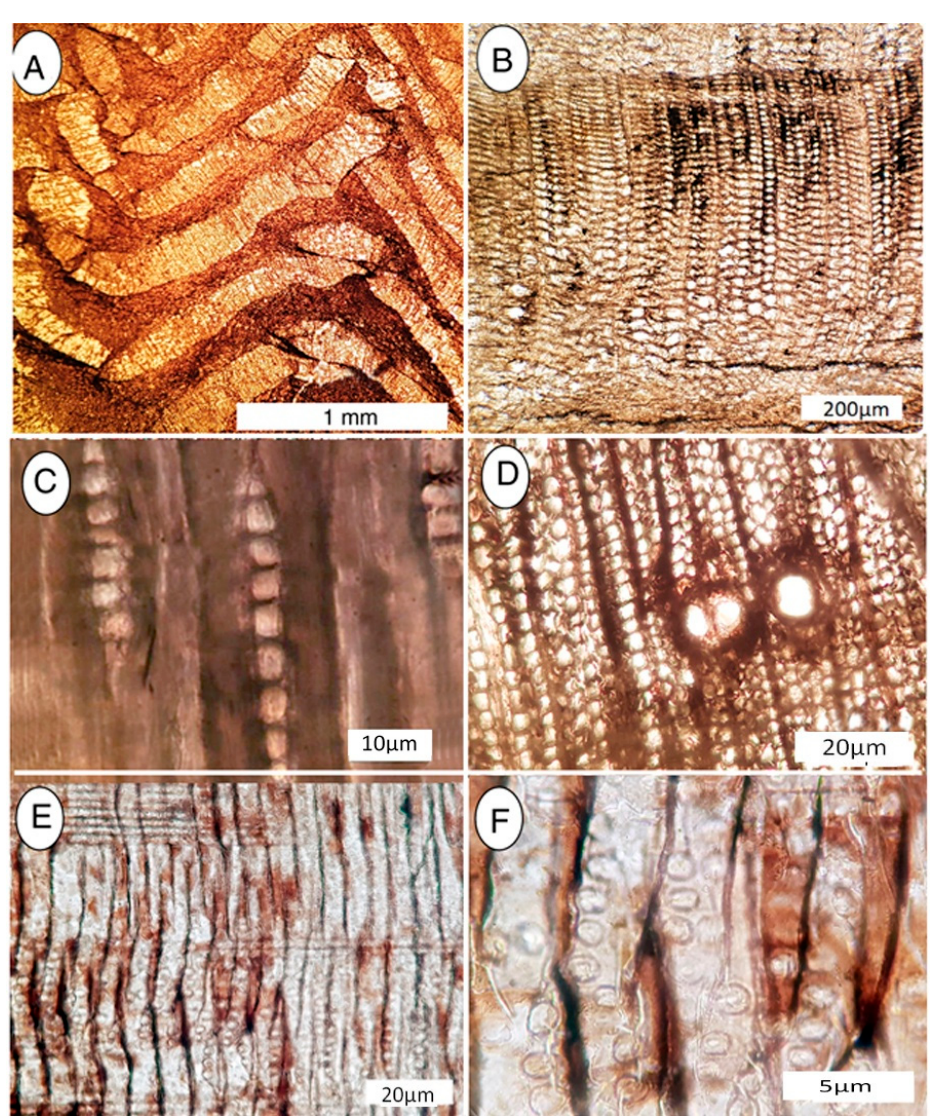
Figure 8. Anatomical characteristics of gymnosperm wood from Meshgin Shahr Fossil Forest. ( A )Transverse view, Trunk 8, showing distortion and compression of annual growth rings. ( B ) Transverse view, Trunk 4, displaying gradual transition between earlywood and latewood. ( C ) Tangential view, Trunk 12, uniseriate ray cells seen in cross section. ( D ) Transverse view, Trunk 12, showing resin canals. ( E ) Radial view, Trunk 7, with fusiform tracheids and horizontal ray cells. ( F ) Radial view, Trunk 7, showing bordered pits typical of conifers. Only one fossil trunk (Trunk 10, represented by sample T-19) is an angiosperm, as shown in